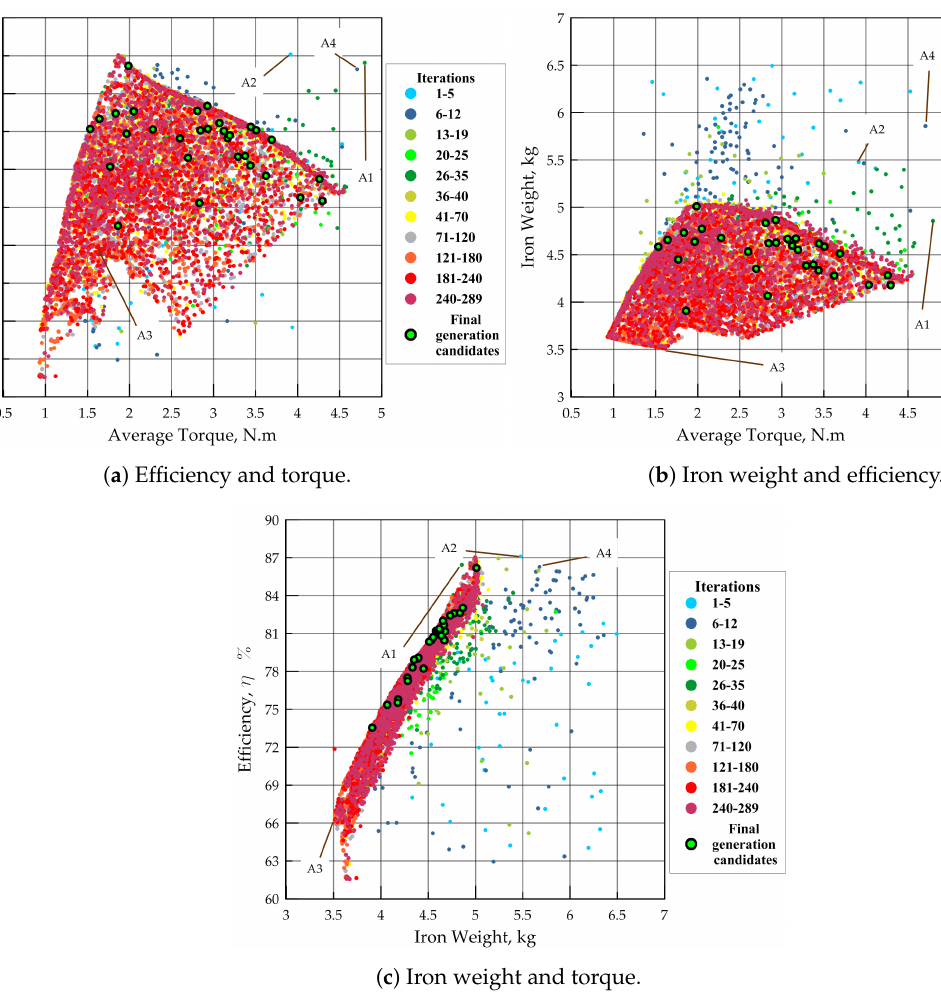
Figure 5. Objective functions results for 8/6